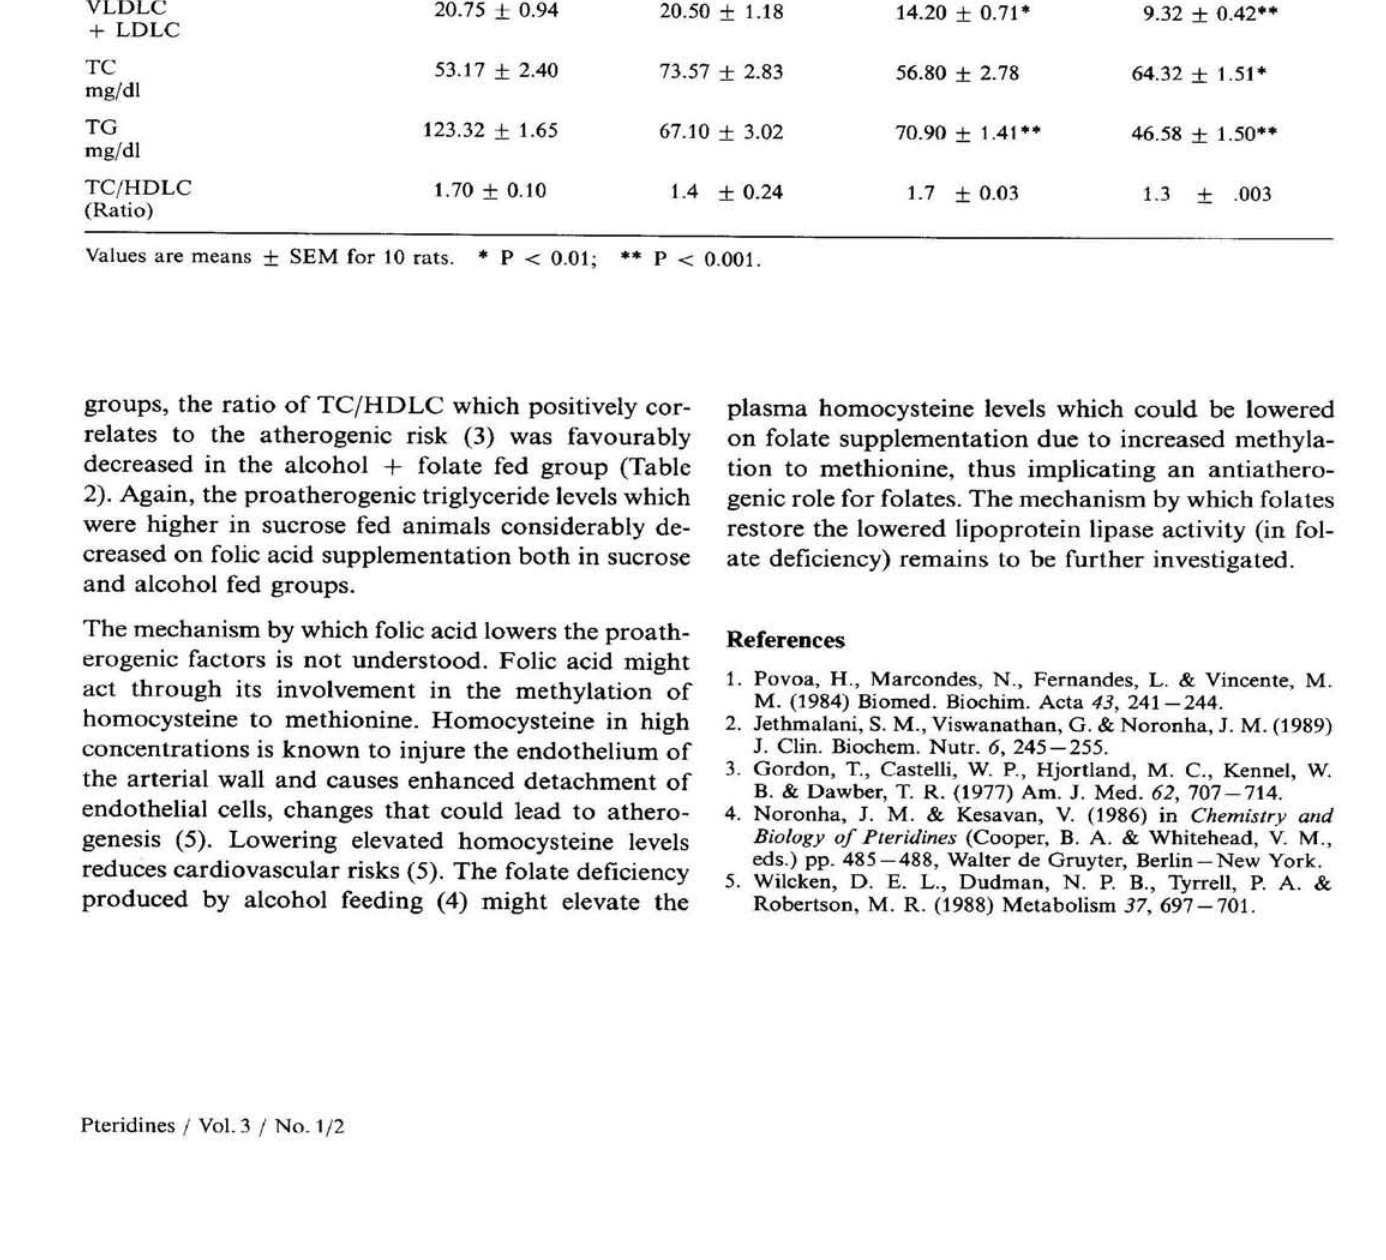
Table 2. Plasma lipoprotein levels in alcohol-induced folate deficient and folate supplemented